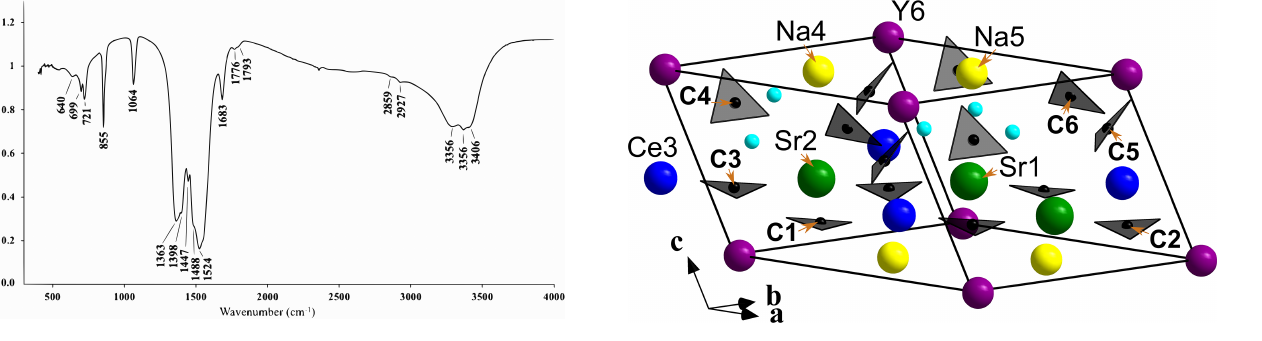
(YCe). Sky-blue spheres are H 2 O molecules. The unit cell is out- lined.